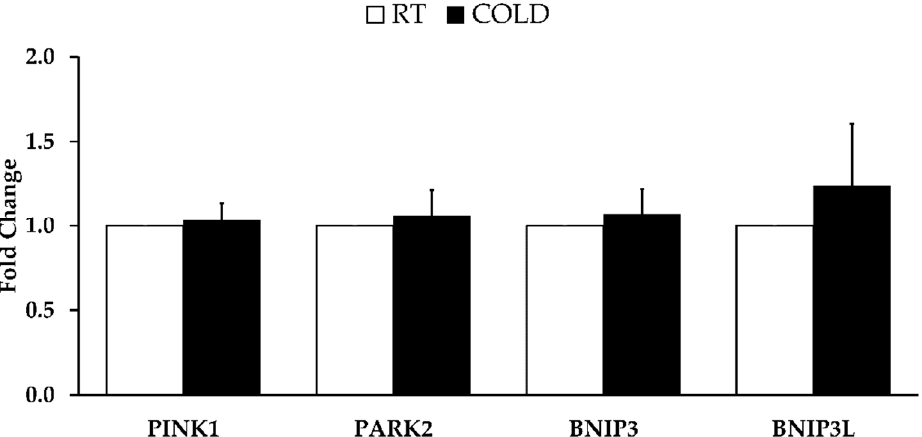
Figure 2. Skeletal muscle mitophagy-related mRNA expression 4 h post cold application. Shown genes include: PTEN-induced putative protein kinase 1 ( PINK1 ), Parkin RBR E3 Ubiquitin Protein Ligase ( PARK 2 ), Bcl-2/adenovirus E1B interacting protein ( BNIP3 ), and BNIP3-like ( BNIP3-L ). Data are mean ± SE.